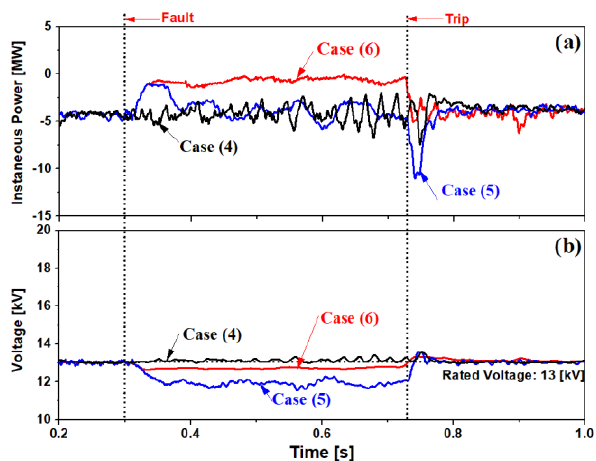
Figure 16. Simulation Results in Case (4)–(6): ( a ) Instantaneous Power of VSC (Voltage Sourced Converter); ( b ) DC Link Voltage.